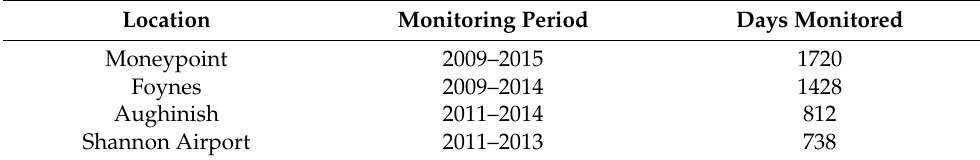
Table 1. Monitoring period and days monitored for every location.